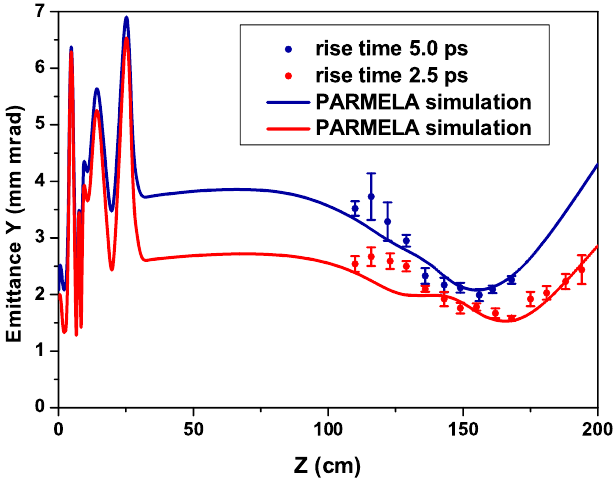
FIG. 17. (Color) Longitudinal laser profile. The pulse length is 9 ps FWHM, and the rise time is about 2.7 ps. The best bright- ness has been obtained with this